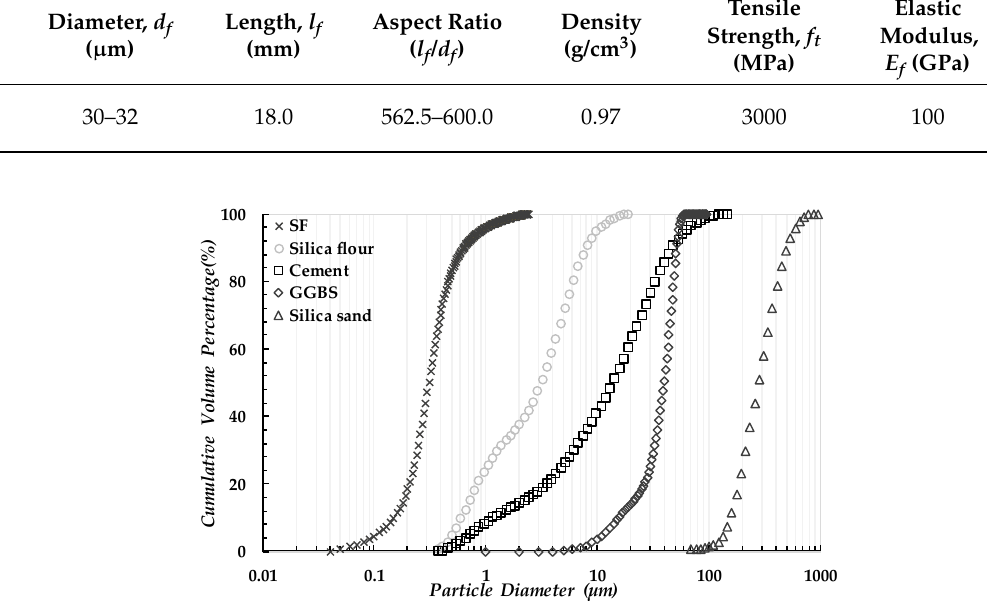
Figure 1. Cumulative volume percentage and particle size distribution.